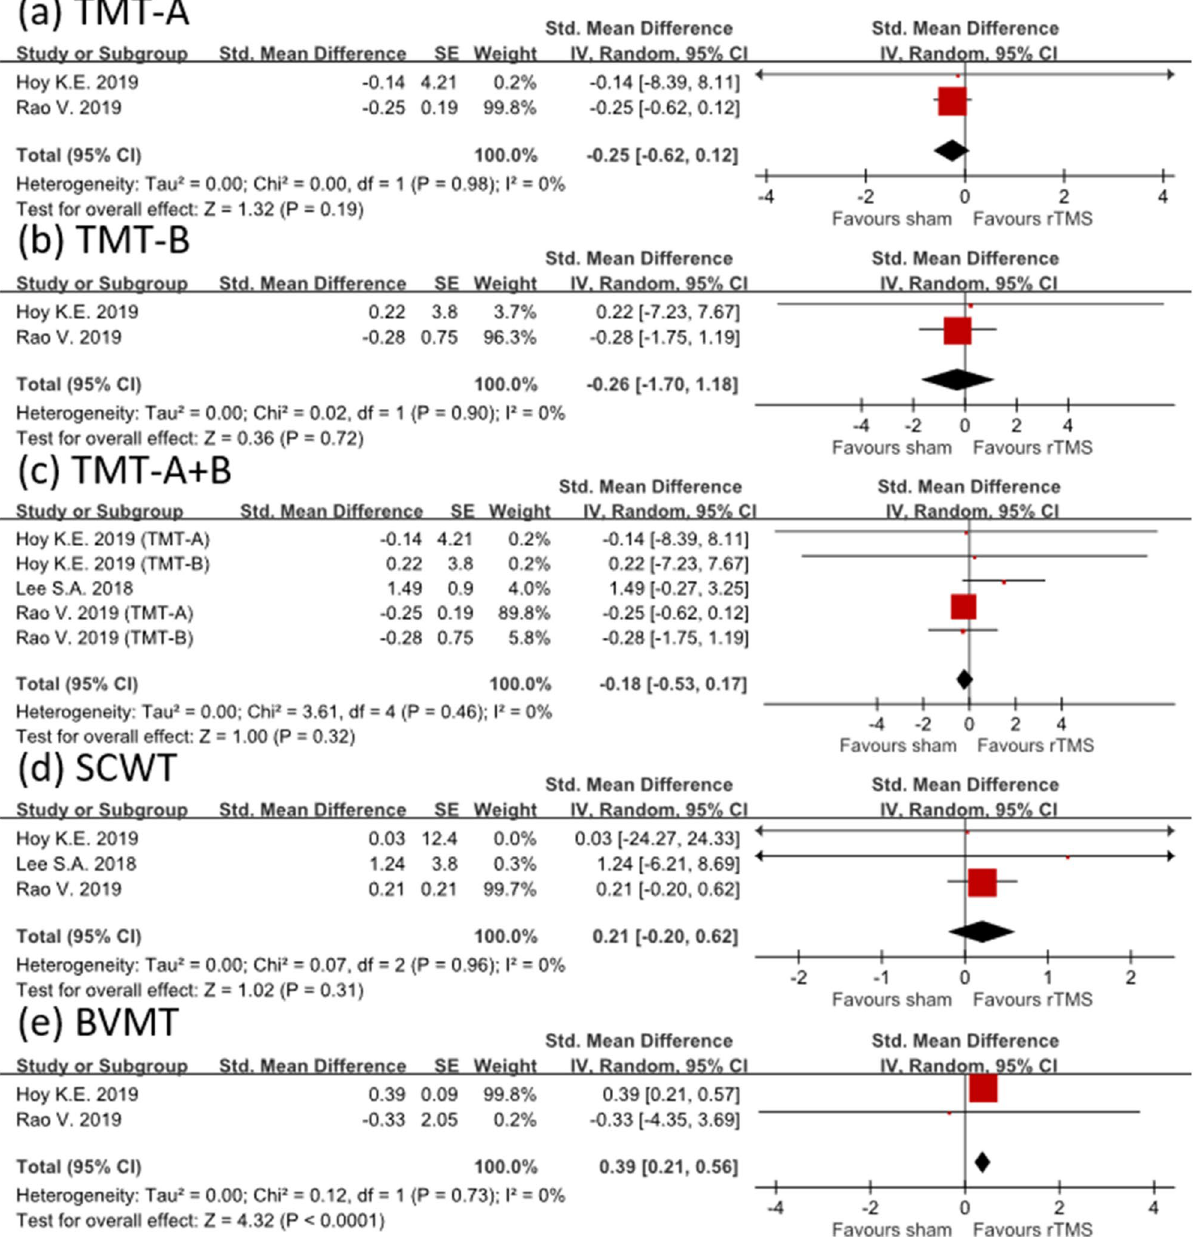
Figure 3. Forest plot showing efficacy of treatment versus sham treatment in improving cognitive function. Different cognitive domains, including ( a – c ) processing speed, ( d ) selective attention, and ( e ) visuospatial memory, were